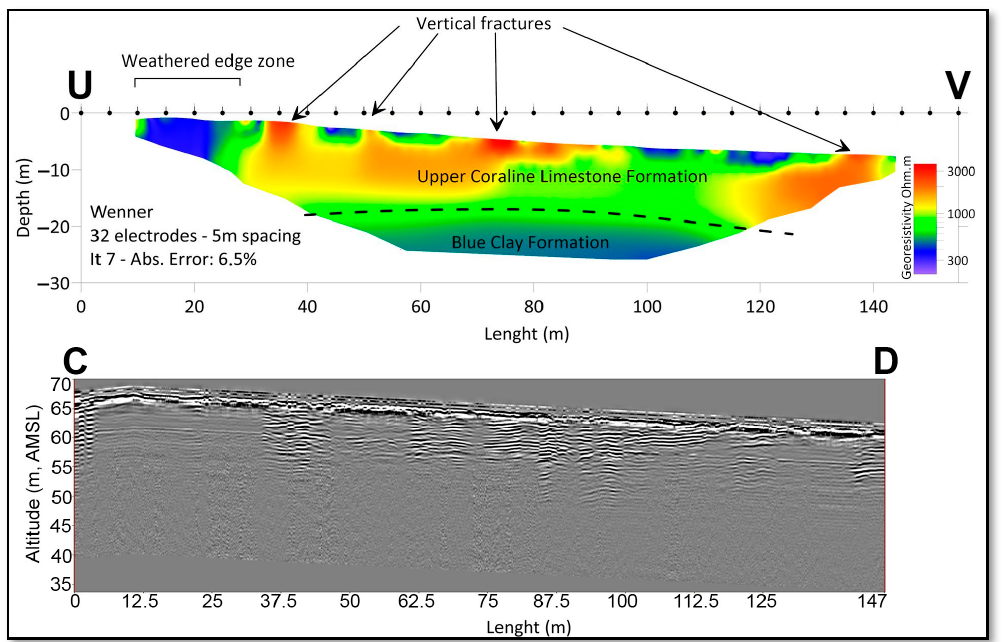
Figure 10. Comparison between ERT (U-V) and GPR (C-D) profiles acquired along the same line on the Selmun plateau (Malta). The black dashed line indicates the stratigraphic contact between upper coralline and blue clay.